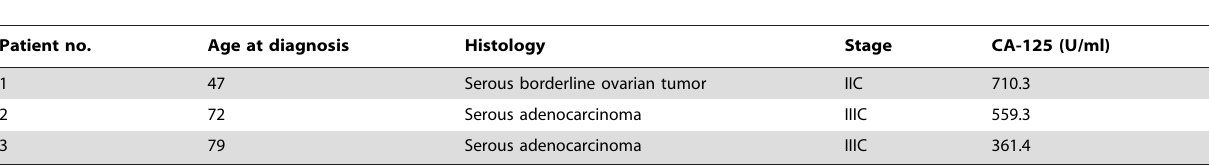
Table 1. Overview of subgroup and stage of the patient samples used for proteomic analysis.